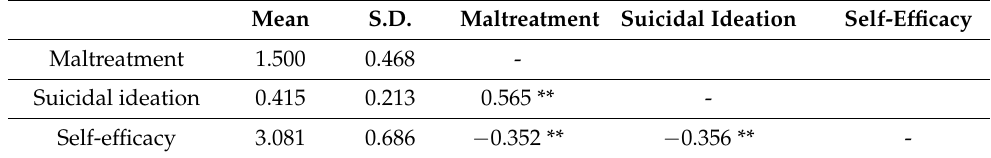
Table 2. Pearson correlations among key